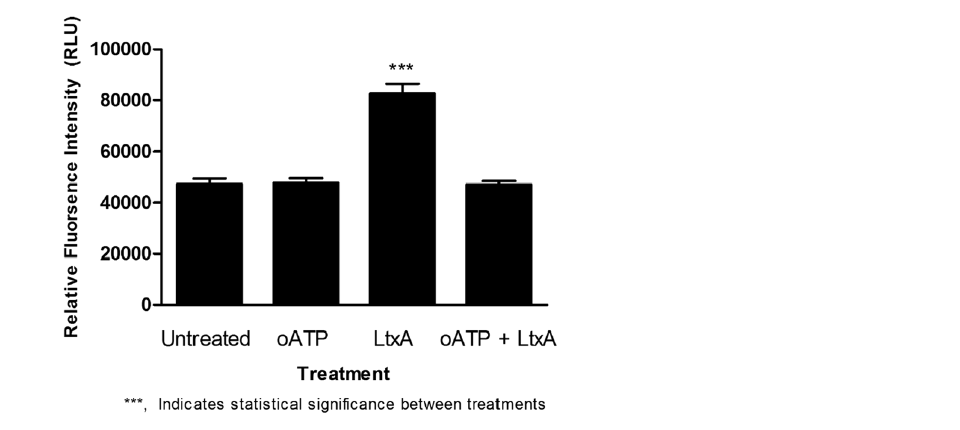
death pathway was not affected in Panx1 K/O cells (Fig. 6, STS control). To corroborate the LtxA resistance data generated through the Annexin V assay, caspase activation assays were also performed. As shown in Fig. 7, K/O of Panx1 reduced LtxA mediated caspase activation (-3/-7, -8, and -9) to control levels while having no effect on the activation of caspases via staurosporin. Further, the cleavage of PARP following treatment with LtxA was also reduced in Panx1 K/O cells (Fig. 8). With the significant reductions in LtxA mediated cell death following Panx1 K/O, we examined whether Fas or LFA-1 surface expression was affected, as these two receptors are known to be critical for LtxA induced cell death of Jurkat cells 19,31 . Through flow cytometry, it was determined that there was no decrease in LFA-1 or Fas surface expression as the result of our CRISPR/Cas9 mediated K/O of Panx1 (data not shown). This indicates that there is a close connection between Panx1, ATP, PARP cleavage, and caspase activation in relation to LtxA induced cell death of Jurkat cells. It is known that the activation of P2X 7 R may lead to cytotoxicity and act in a way to upregulate cell death in response to pathological insults 32 . During pro-inflammatory responses and tissue injury, release of ATP into the extracellular environment has shown to activate P2X 7 Rs, resulting in apoptotic and necrotic forms of cell